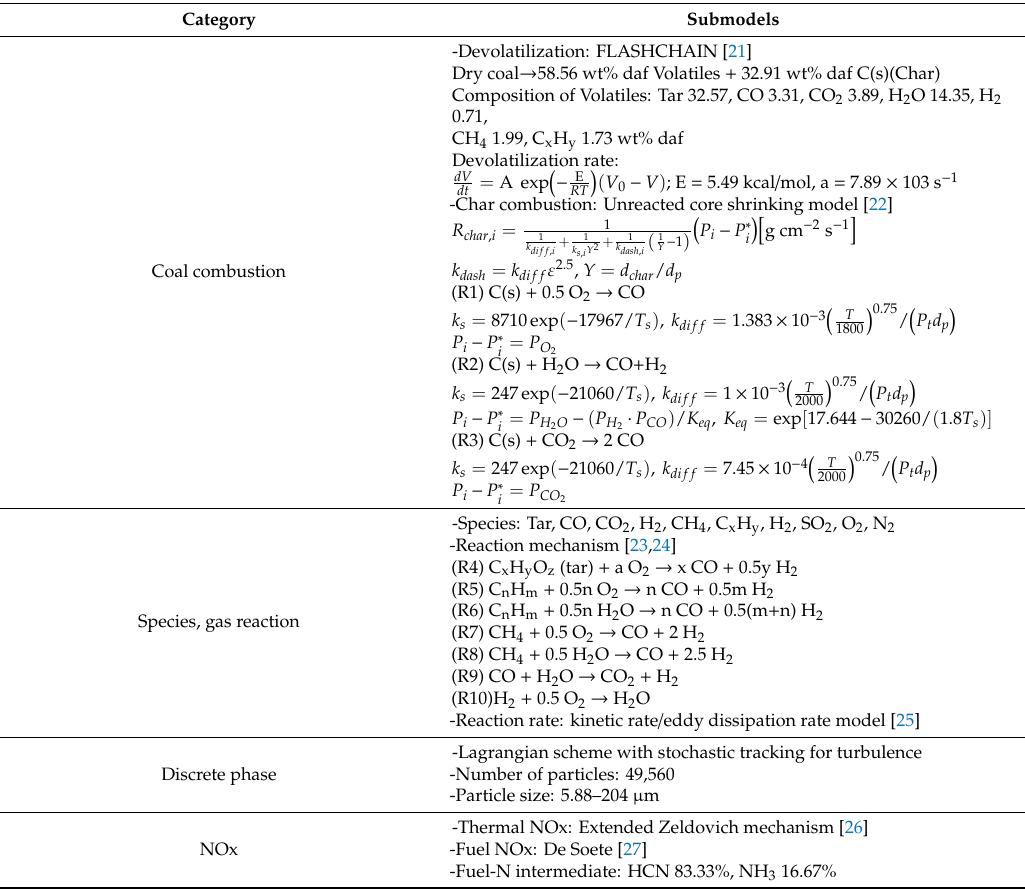
Table 3. Summary of submodels adopted for boiler